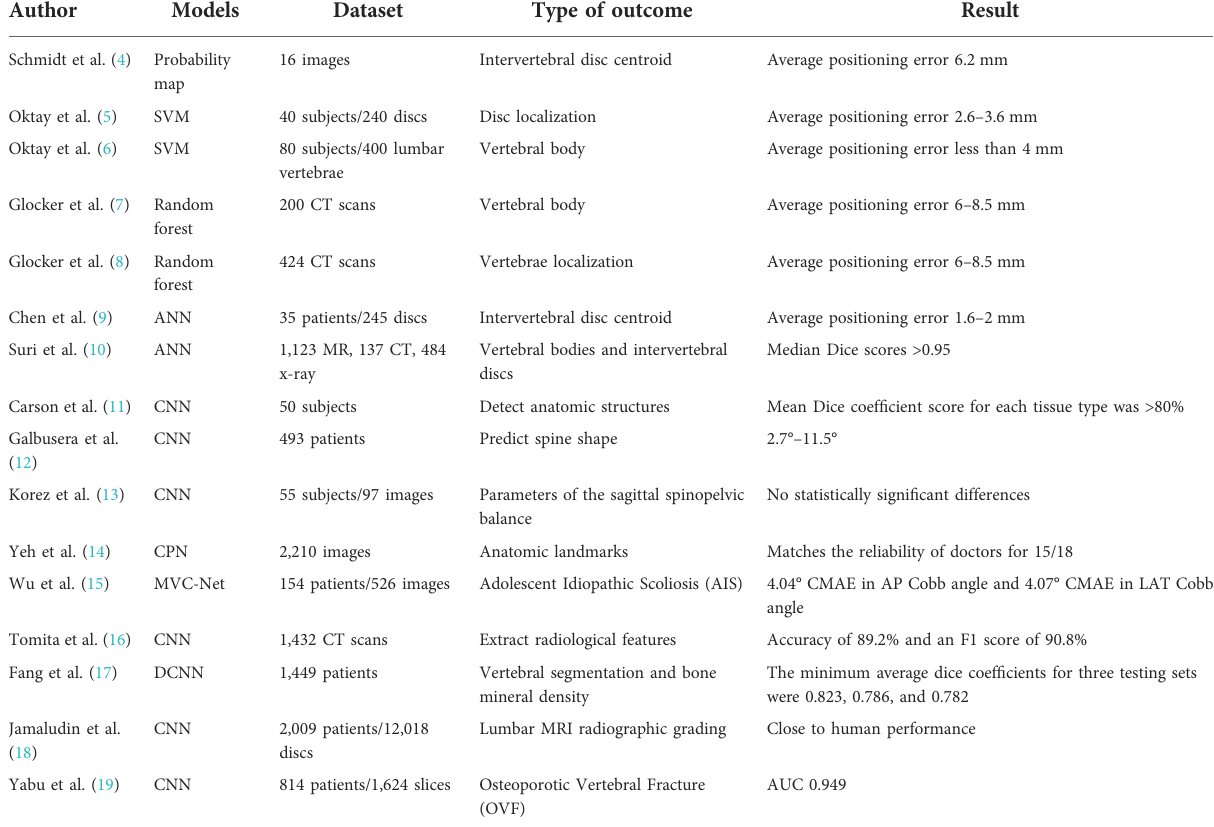
TABLE 2 AI and ML in the diagnosis of spinal